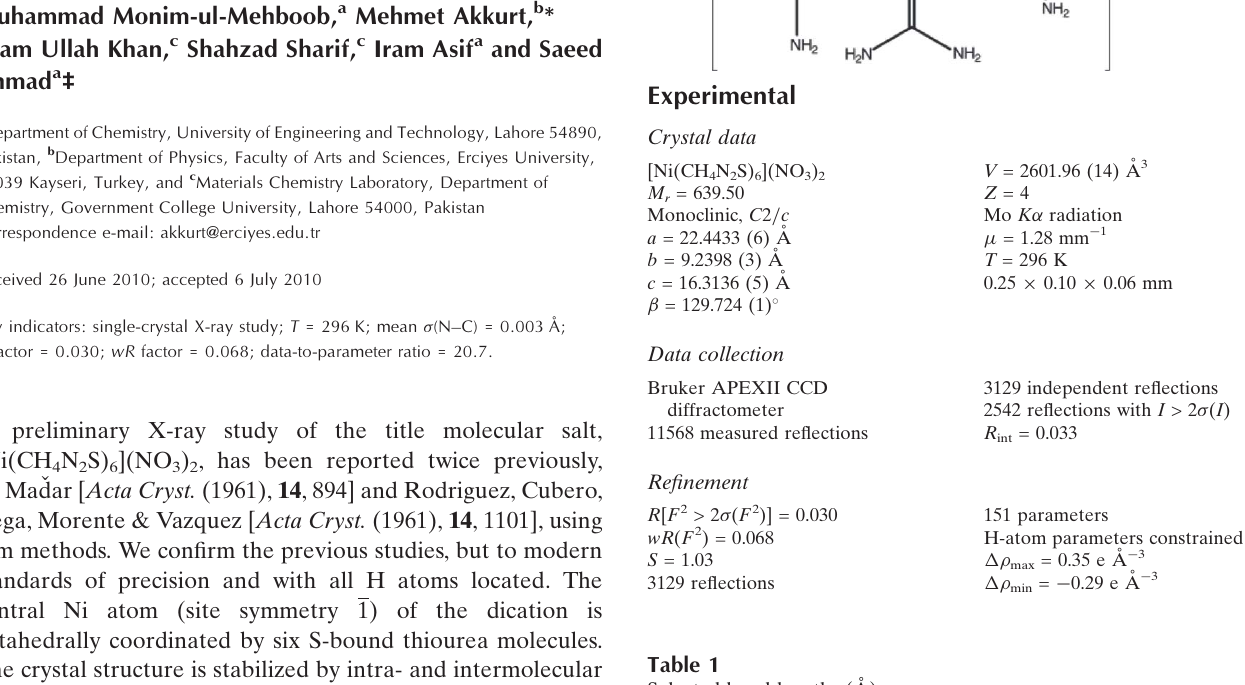
Selected bond lengths (A˚ ).